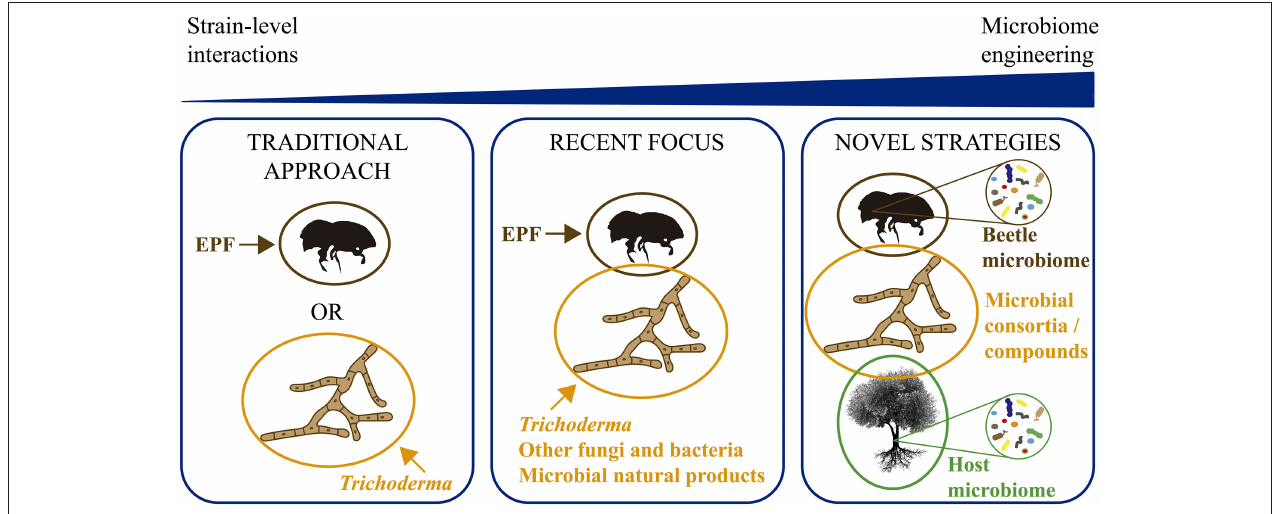
FIGURE 1 | Overview of the different microbe-based approaches for the biocontrol of ambrosia beetles and their pathogenic fungi. The traditional approach has been focused on studying the antagonism displayed by single strains of entomopathogenic fungi (EPF) or Trichoderma spp. against ambrosia beetles or their associated fungi. Recent works have been integrating both strategies to tackle ambrosia fungi and their vectors at the same time, exploring other sources of biocontrol agents. Novel, cutting-edge strategies aim at manipulating the beetle microbiome in order to reduce its fitness, or the host microbiome in order to steer beneficial